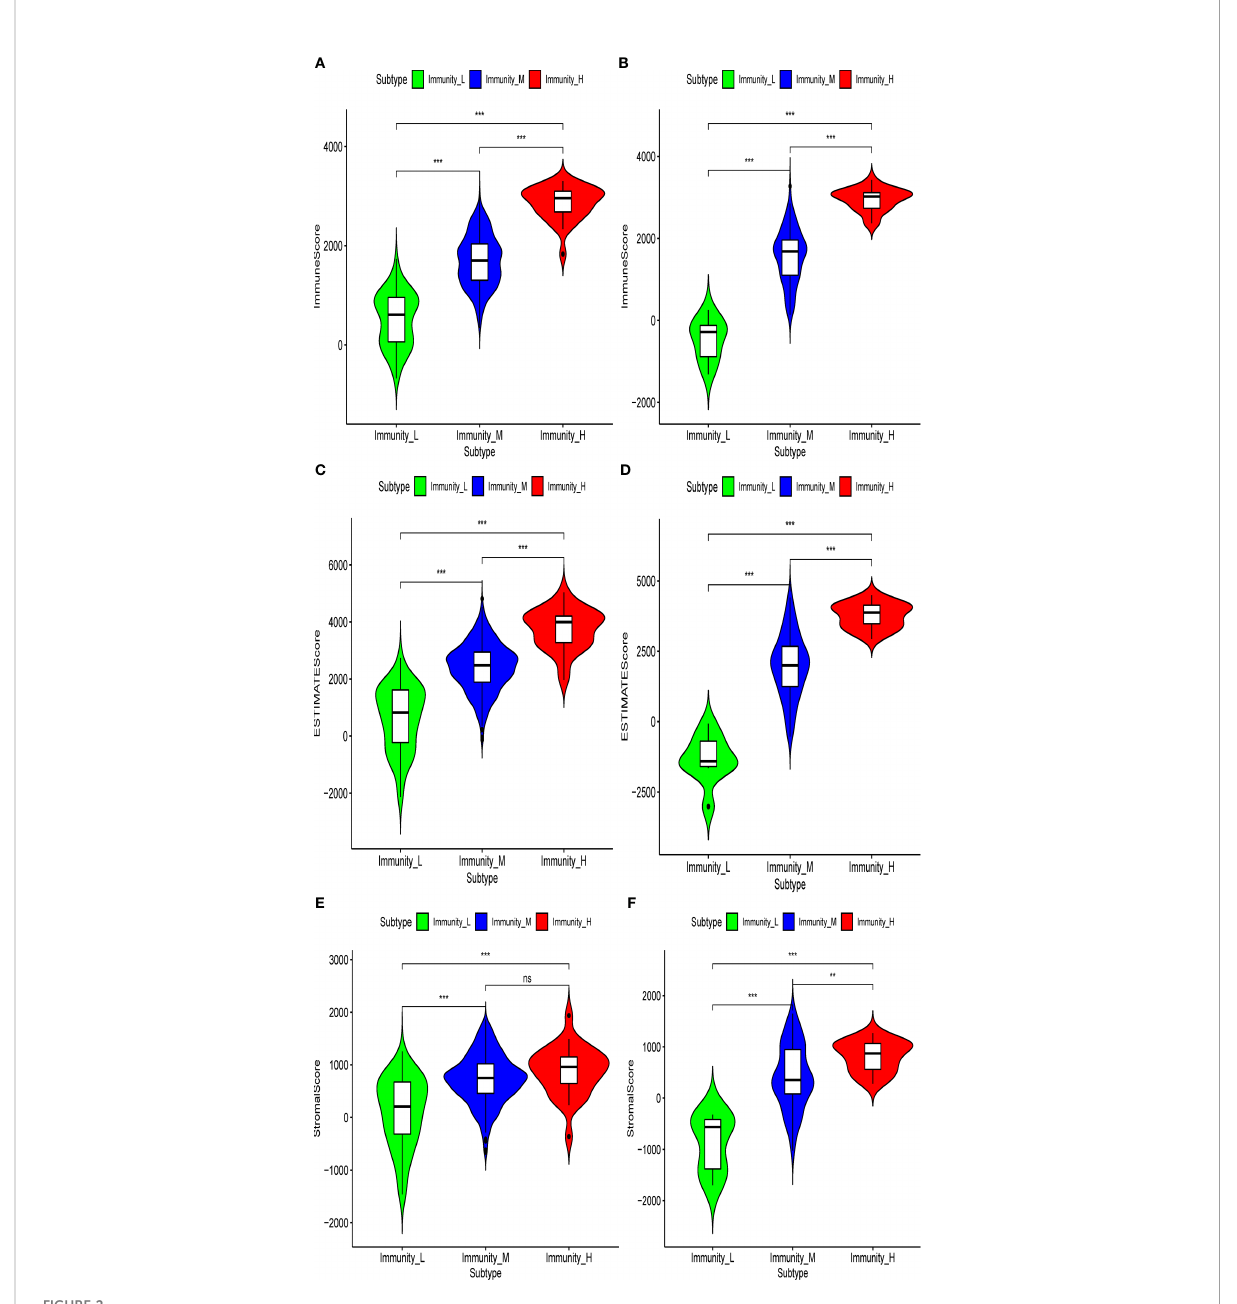
FIGURE 2 Violin plot showed ImmuneScores, ESTIMATEScores, and StromalScores in different immunity groups in the discovery set and validation set. ImmuneScores in the discovery set (A) and validation set (B) . ESTIMATEScores in the discovery set (C) and validation set (D) . StromalScores in the discovery set (E) and validation set (F) . **p < 0.01; ***p < 0.001. ns, not signi fi